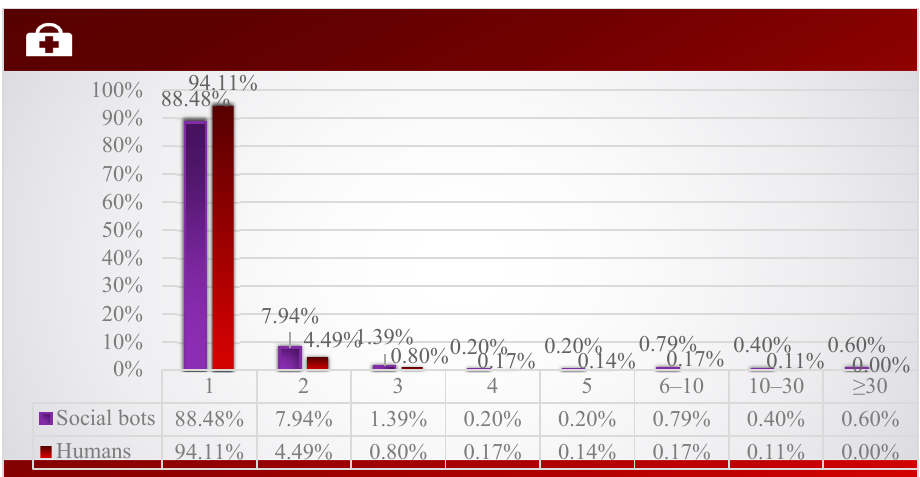
Figure 13. Distribution of tweets number of social bots and humans.